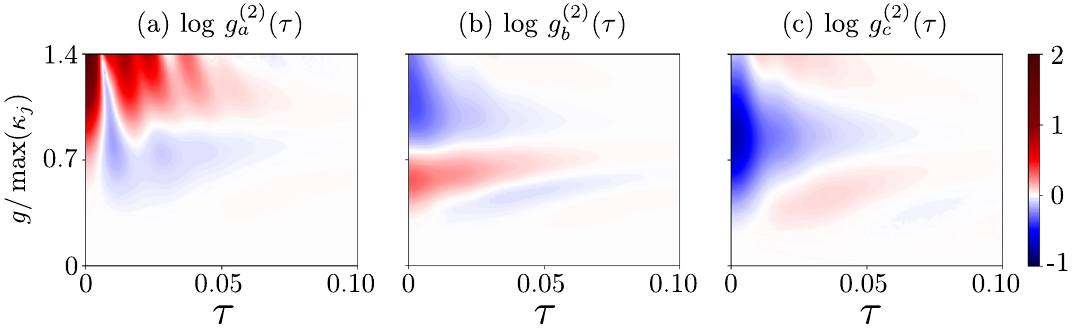
Figure 6. Same as in Fig. 4, but for the QD-driven system with parameters given in Eq. (29). We observe here single-PRs and the corresponding single-PB